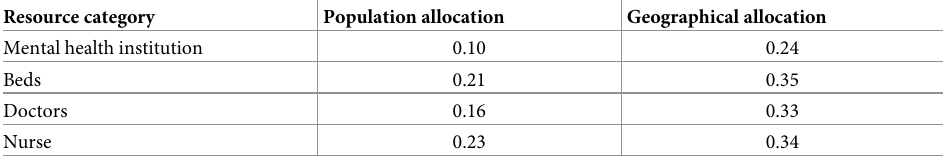
Table 5. The Gini coefficient of resource allocation of mental health institutions. Resource category